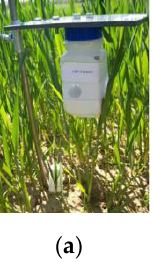
Figure 2. Passive-flux-collector from a square bottle with a modified acid trap for NH 3 ( a ) and Dräger- Tuber method (DTM) with Teflon tubes for hand pumping ( b ).